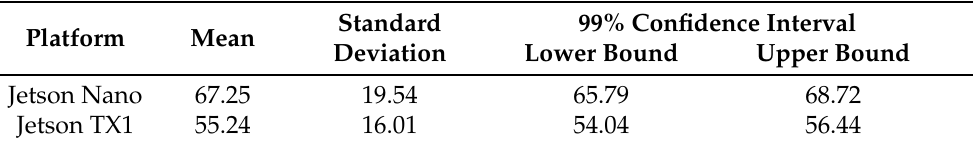
Table 8. The proposed model’s inference time on Jetson Nano and Jetson TX1. The unit of inference time is